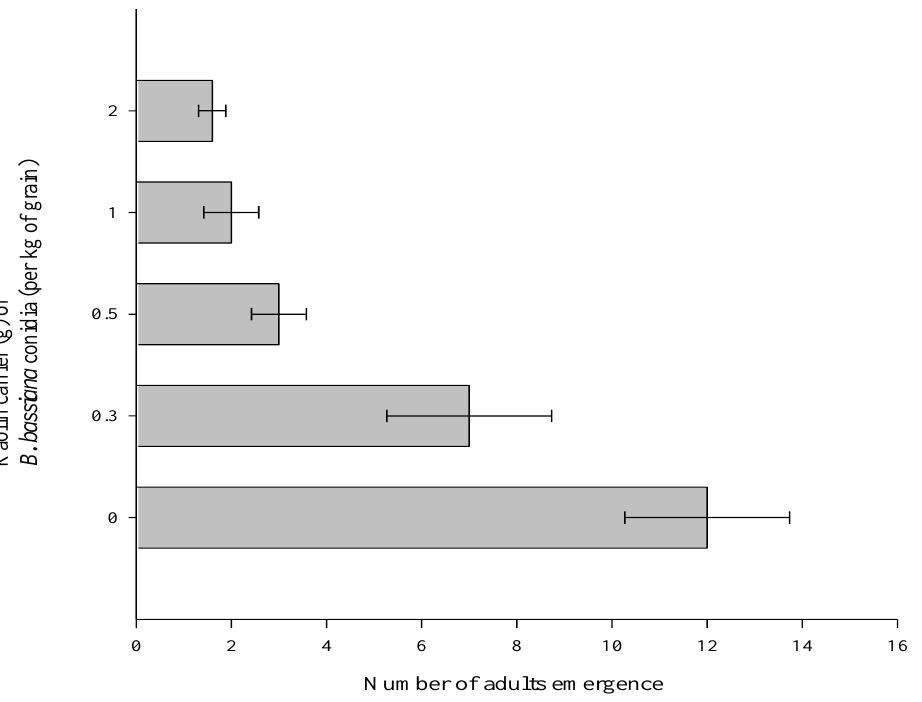
Figure 2. Mean number of Ephestia cautella adults that emerged from rice grains after 45 days of infestation following treatment with Beauveria bassiana Strain MS-8 at 0.03 g conidia kg − 1 formulated in various doses of kaolin.